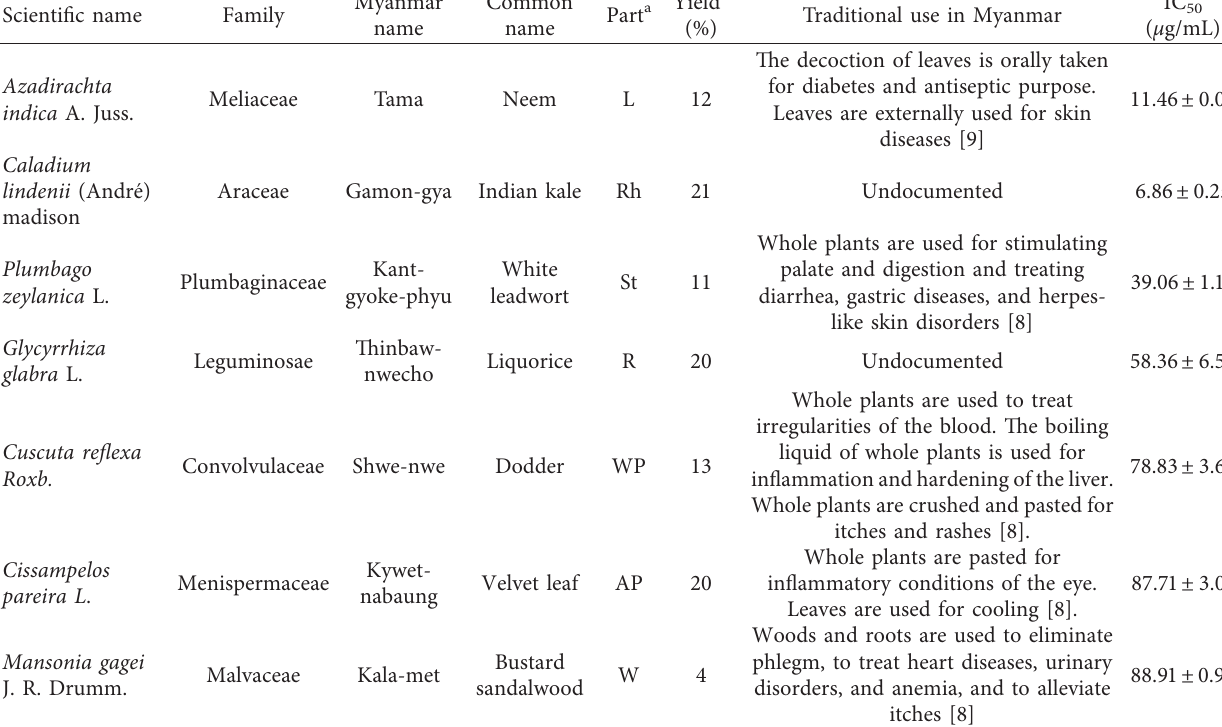
Table 1: Ethnobotanical information and the PPL inhibition activity of seven